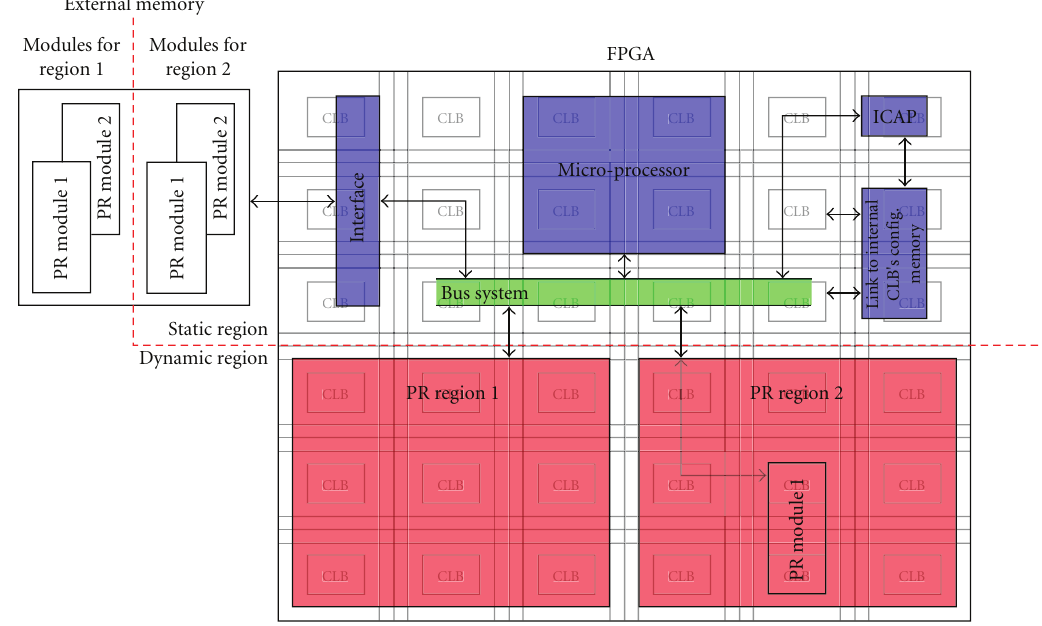
Figure 2: Description of Dynamically Reconfigurable SoC with ICAP